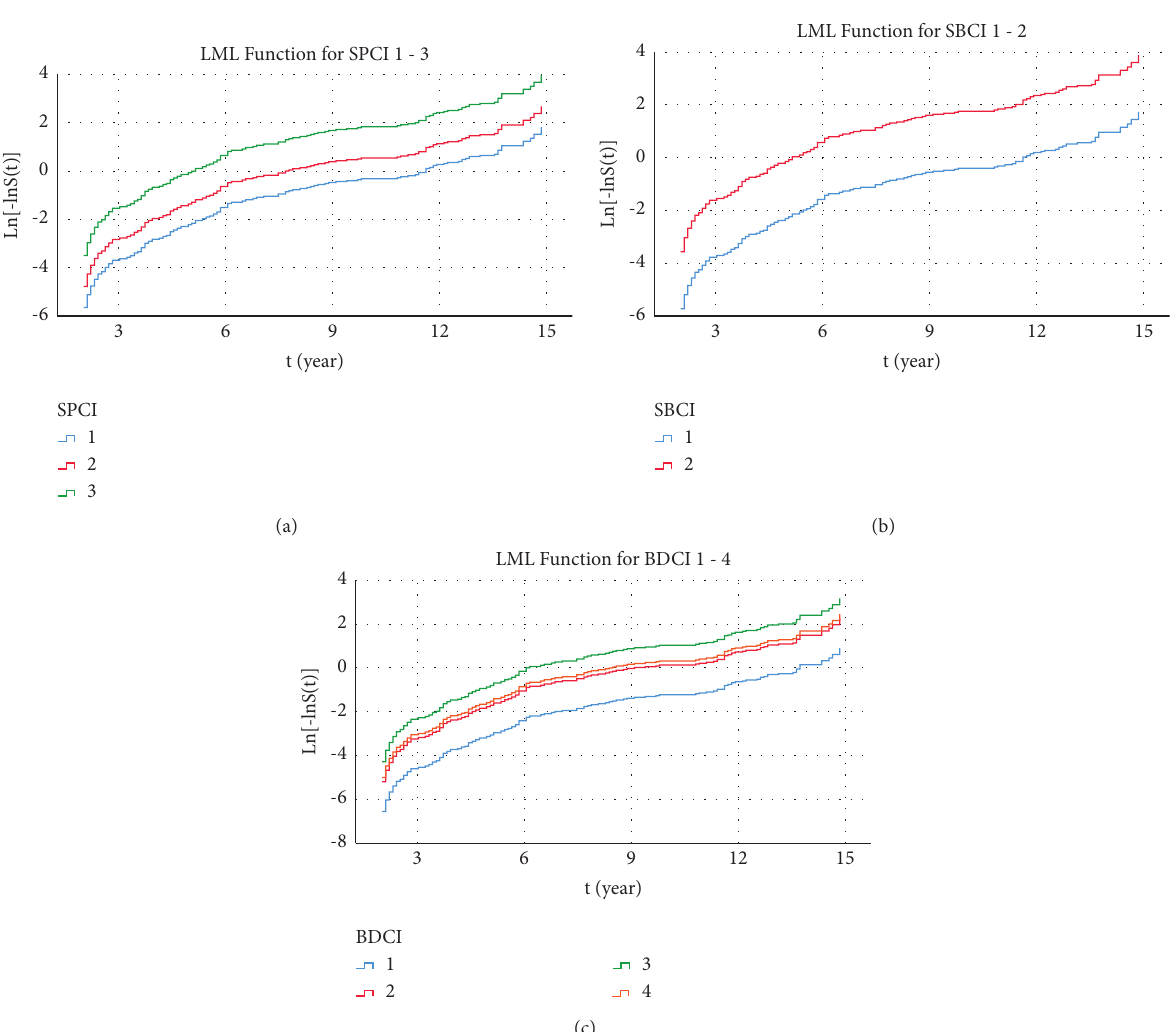
Figure 6: LML curves for the three independent variables; (a) LML curve for the superstructure; (b) LML curve for the substructure; (c) LML curve for the bridge deck system.